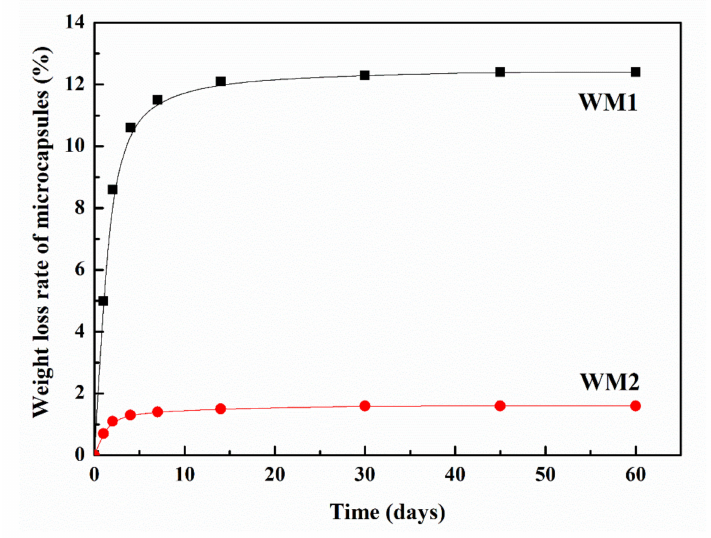
Figure 3. Weight loss rate of